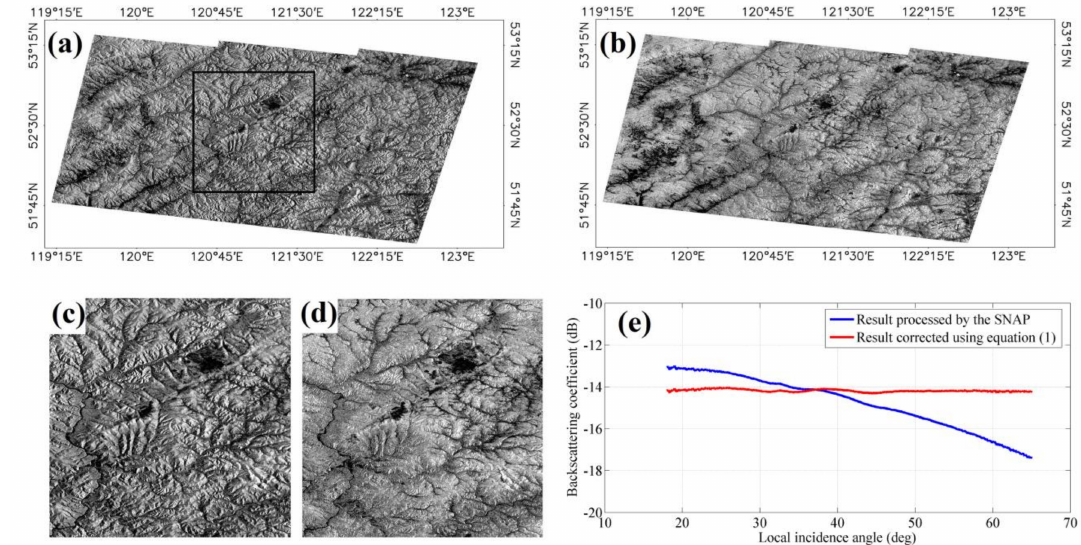
Figure 3. Correction of terrain e ff ects using Equation (1) on images of Strip-1-1 acquired on 12 June 2015: ( a , b ) are the images of cross-polarimetric (i.e., VH) processed by the Sentinel Application Platform (SNAP) and further corrected using Equation (1), respectively; ( c , d ) are enlarged images of ( a , b ) over the area covered by the black box, respectively; ( e ) is the scatter plot of the backscattering coe ffi cient against the local incidence angle before and after the correction of Equation